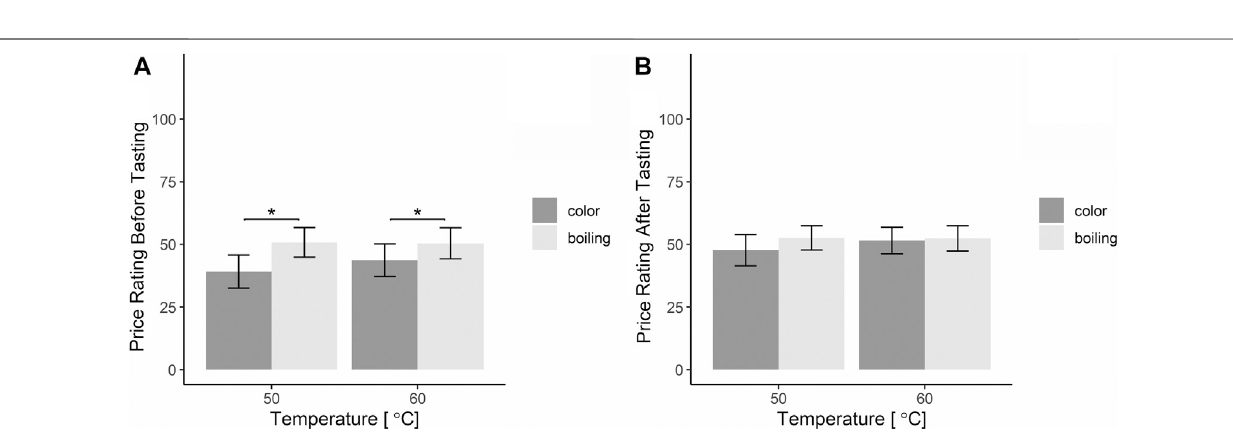
FIGURE 8 | (A) Price ratings before tasting and (B) after